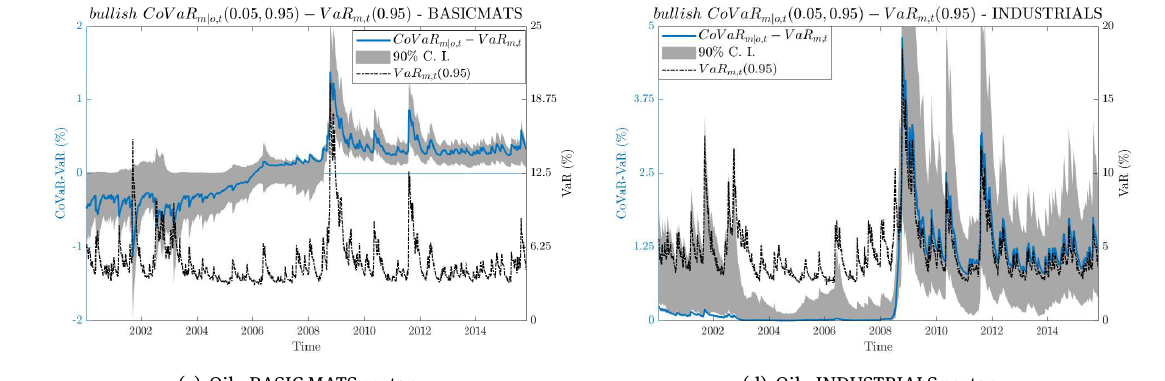
Left axis shows the difference in percentage between the CoVaR (0.05, 0.95) of the returns for a certain sector under a m , t extreme upward movement in oil prices, i.e. above its 95-th quantile, and its unconditional VaR (0.95). Solid blue line shows m , t this difference given the best copula mixture according to Table 6. Grey area indicates the 90% confidence interval of the difference between CoVaR (0.05, 0.95) and VaR (0.95) following a Monte Carlo technique explained in Appendix C. The m , t m | o , t right axes shows the value of the VaR (0.95) in percentage. The dash-dotted black line indicate the VaR level over m , t